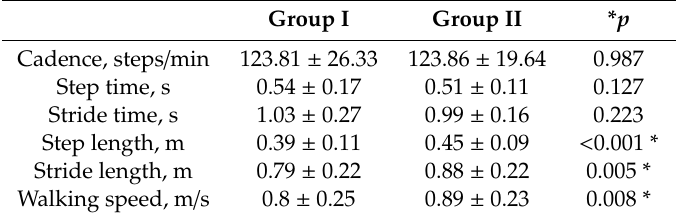
Table 3. Comparisons of temporospatial parameters between the groups.